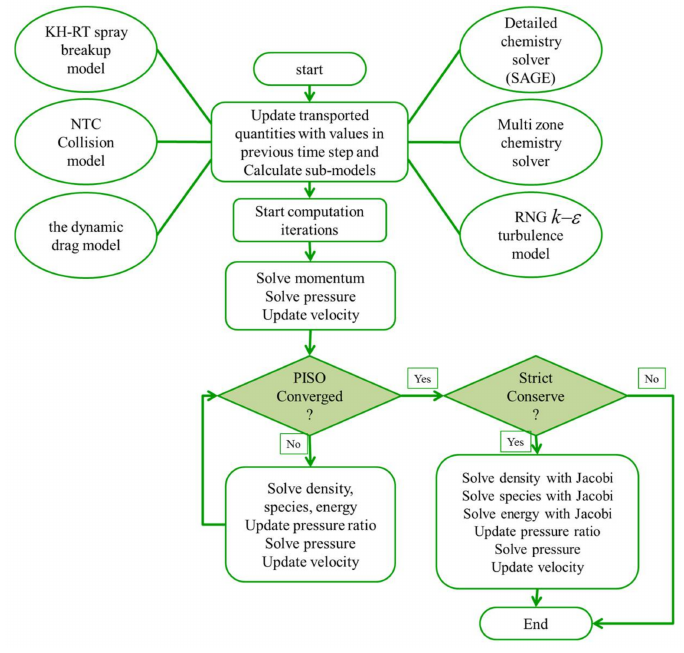
Figure 1. Flow chart of CONVERGE simulation for a single